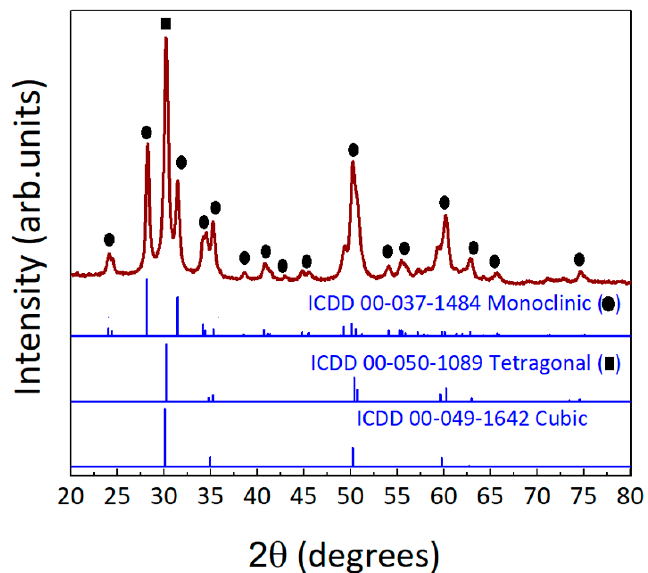
Figure 7. XRD diffractogram of ZrO 2 powder produced by solution combustion synthesis and annealed in air at 350 °C for 1 h (represented in red). For comparison, the simulated monoclinic, tetragonal and cubic zirconia structures are also presented.